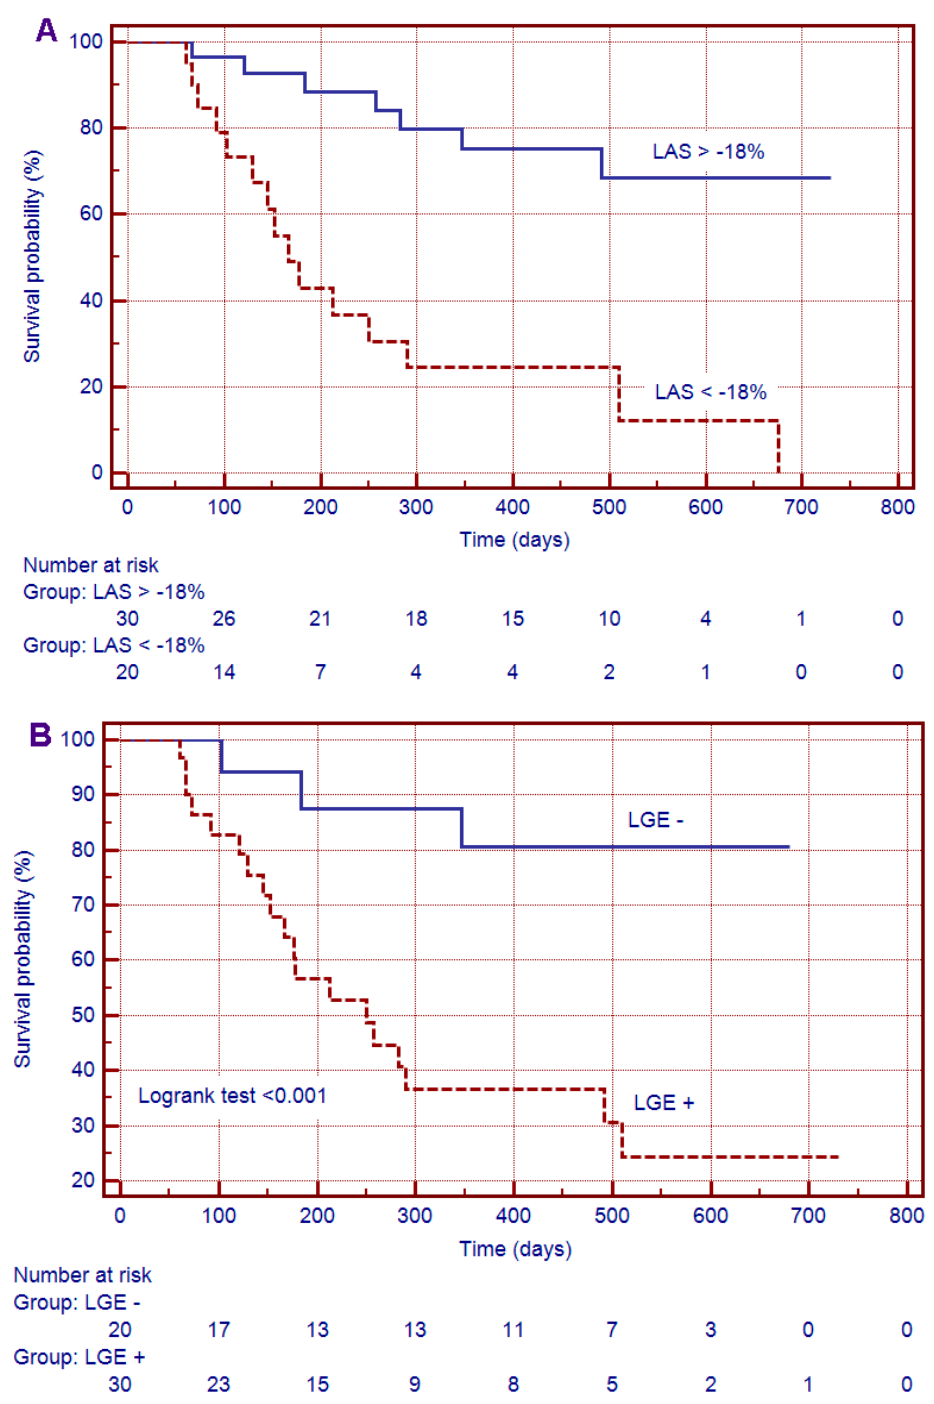
Figure 3. Kaplan–Meier curves for event-free survival for ( A ) Longitudinal Axis Strain (LAS); ( B ) late gadolinium enhancement (LGE).